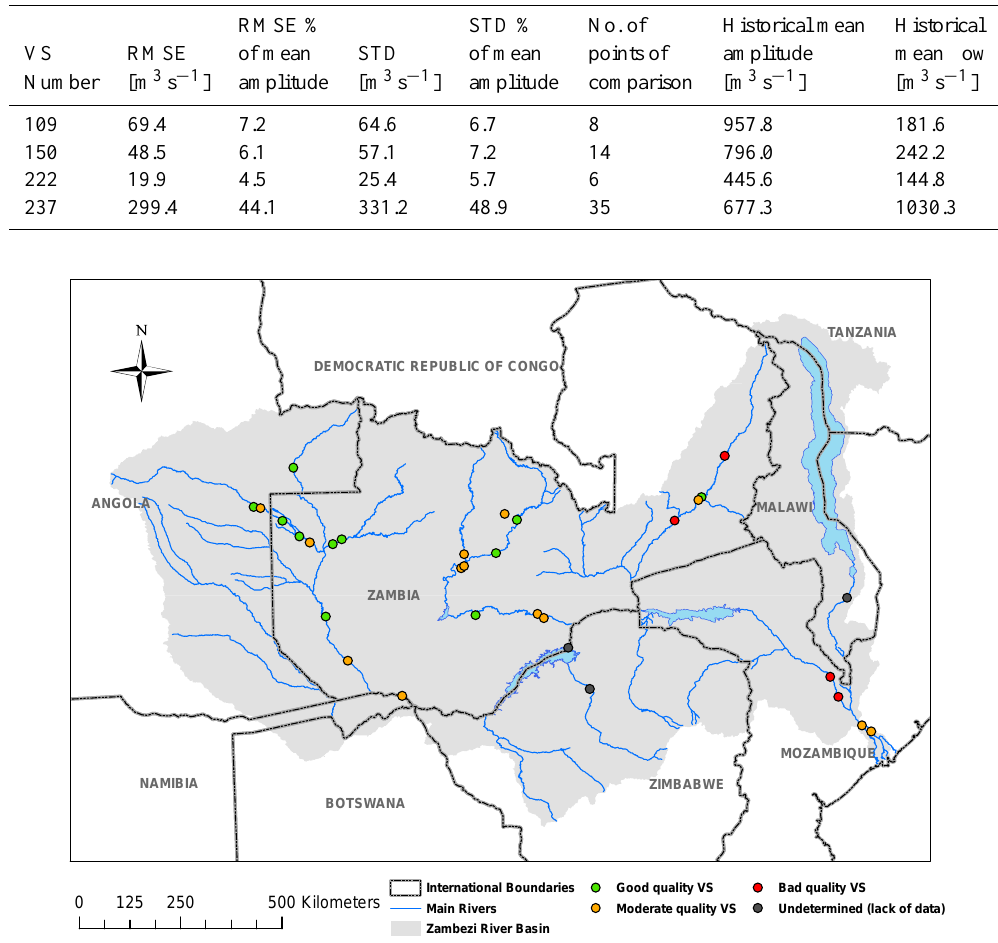
Fig. 4. VS location and quality in the Zambezi River basin.